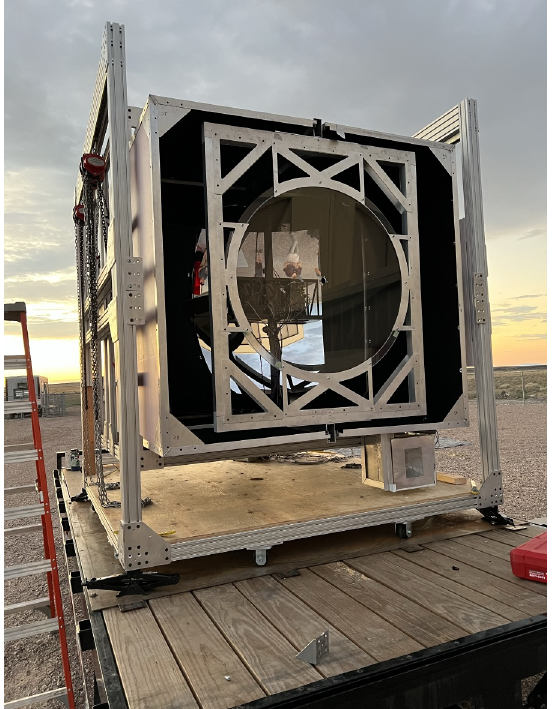
Figure 4: The Fluorescence Telescope during the field Test in August 2022. Yoke structure used for transportation and ground observations allows for full azimuthal rotation and